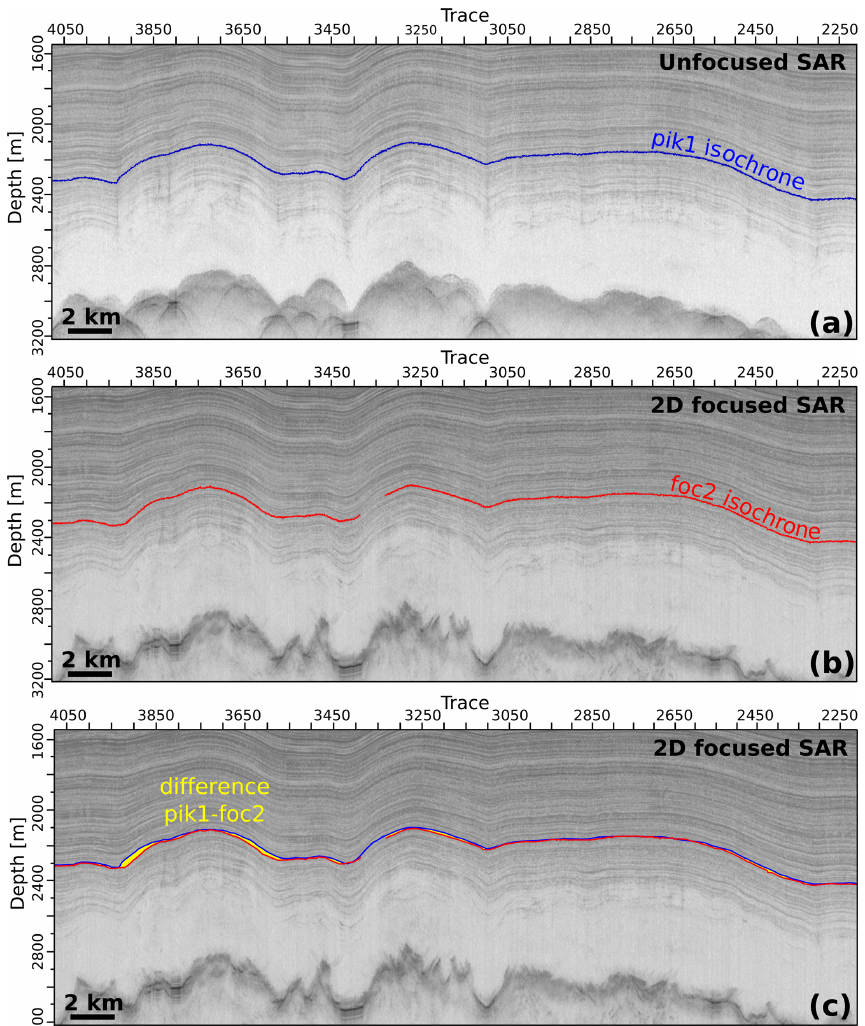
Figure 2. Differences in IRH geometry between different radar processing products: (a) unfocused SAR processed radargram with the corresponding pik1 IRH traced, (b) 2D focused SAR processed radargram with the same IRH traced (foc2) and (c) 2D focused SAR processed radargram with the geometries of the same IRH and their differences plotted as a yellow envelope. Differences are clearly largest where the IRHs are most steeply